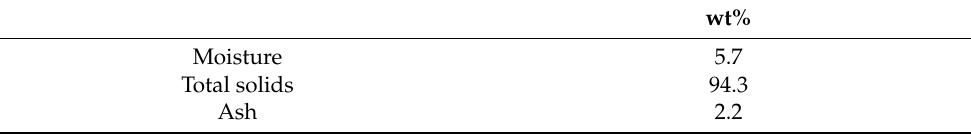
Table 2. Proximal analysis of the ASB.